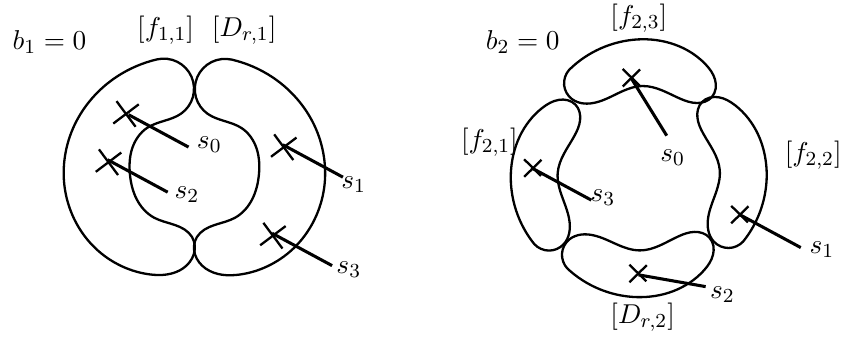
Figure 5 . Depiction of the generic resolved Z 4 torsion model and its intersection with the torsion sections s i . The intersection pattern with the resolution divisors is compatible with the cyclic order four movement for the su (4) (cid:12)bers and an order two subgroup for su (2)